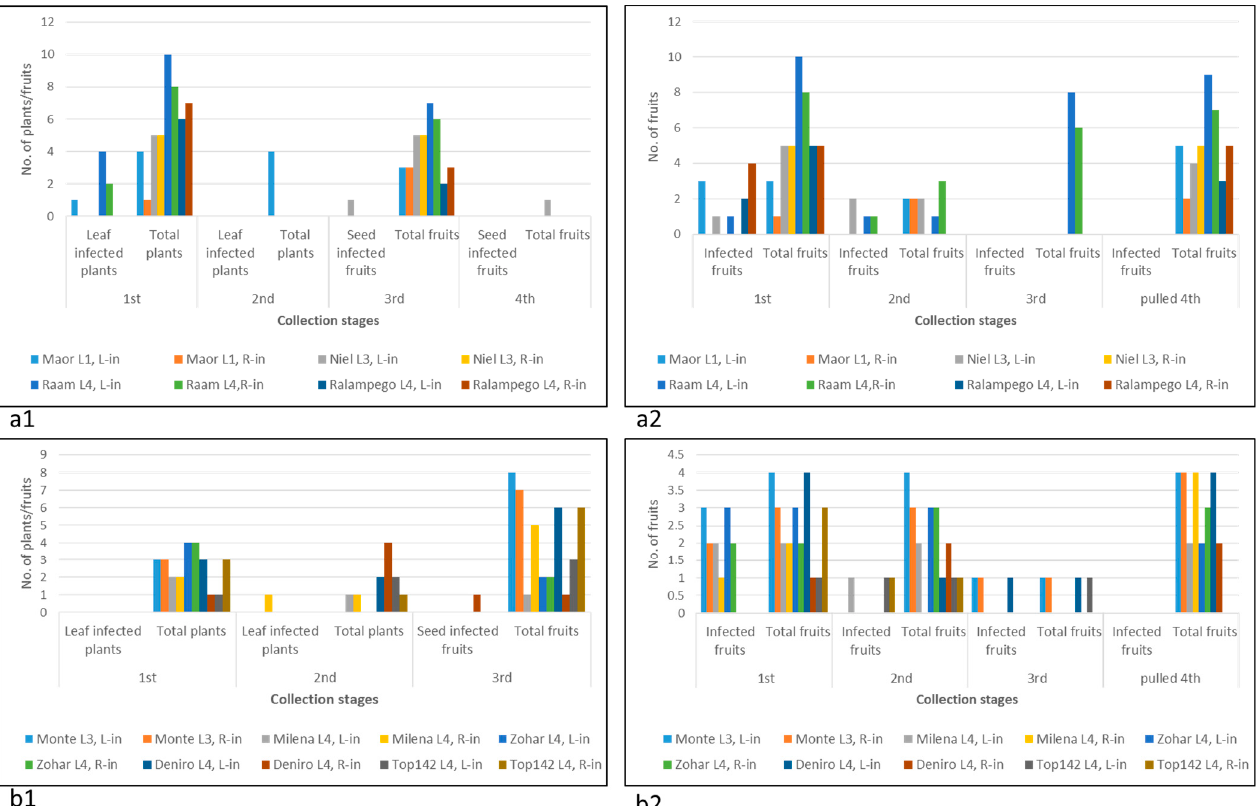
Figure 5. Detection of ToBRFV by ELISA in leaves, fruits, and seeds of leaf- or root-inoculated L 1 , L 3 , and L 4 pepper cultivars: ( a1 , b1 ) detection of ToBRFV infection of leaves and seeds; ( a2 , b2 ) detection of ToBRFV infection of fruit pericarp; pulled 4th, unscheduled collections of fruits; L, leaf inoculations; R, root inoculations.